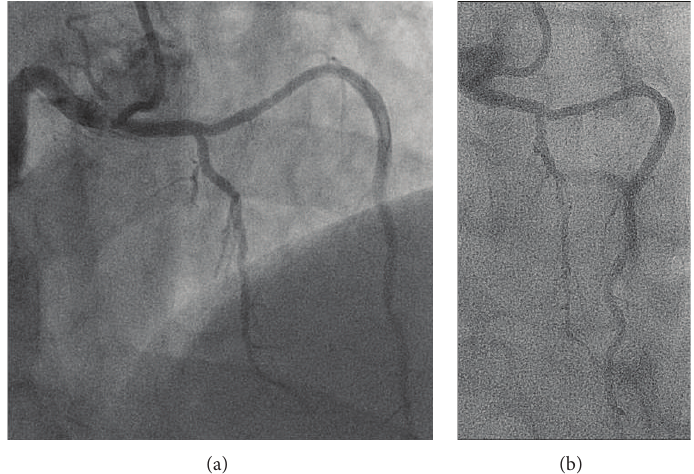
Figure 3: The “long” LAD artery, from the right sinus of Valsalva, close to the RCA ostium (a), until the distal part of the AIVS, after the emergence of a large septal branch (b). LAD, left anterior descending artery; RCA, right coronary artery; AIVS, anterior interventricular